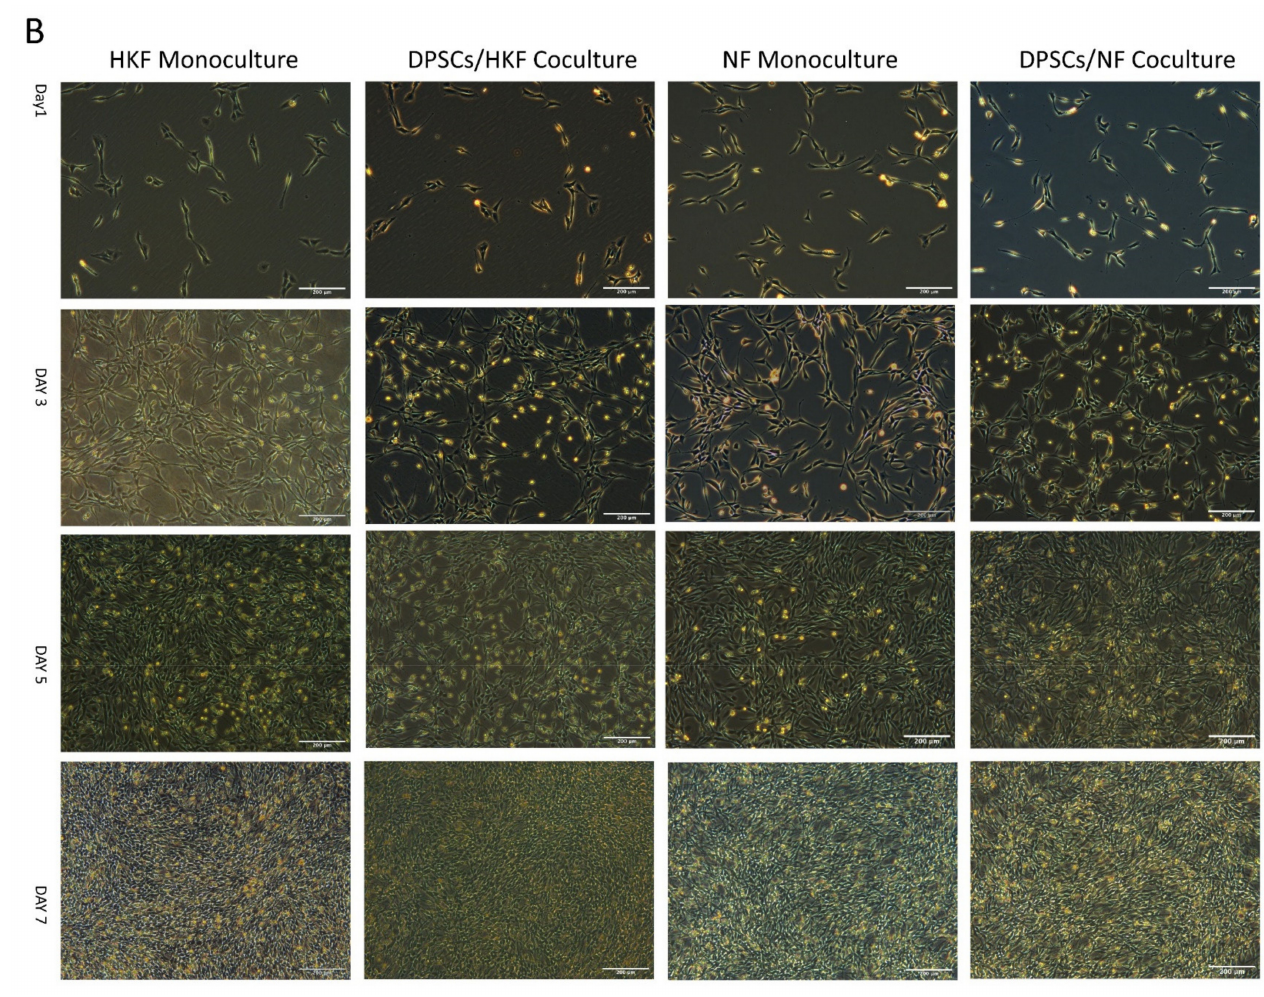
Figure 4. ( A ): The cell counts (proliferation) were analyzed using CCK-8 kits (Dojindo) on days 1, 3, 5, and 7. ( B ): The morphology of the fibroblasts was determined on days 1, 3, 5, and 7 by direct observation with a light microscope. Scale bar: 200 µ M. HNFs: human normal fibroblasts, HKFs: human keloid fibroblasts, HDPSCs: dental pulp stem